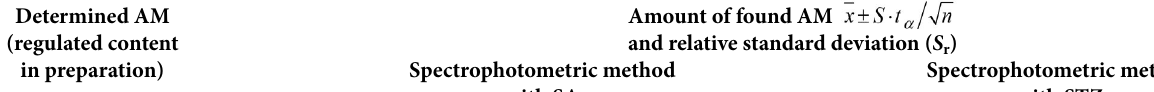
= 7.2 ∙ 10 –3 М, С НСІ = 0.7 М, С SТZ = 3.6 ∙ 10 –4 М, C NaNO 2